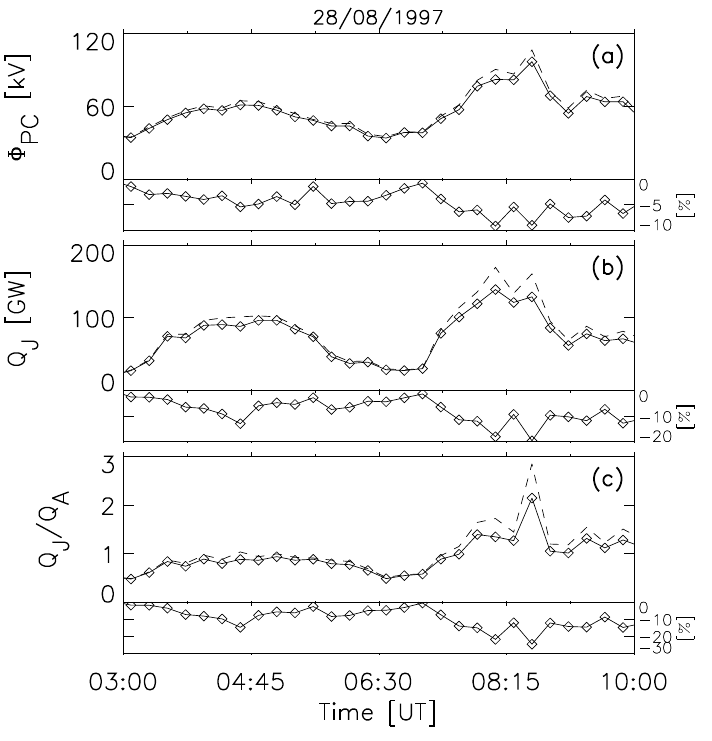
Fig. 13. The AE , AL and D st -indices between 00:00 and 12:00 UT on 28 Au- gust 1997. AE and AL are calculated from 68 stations between 55 and 76 ◦ in magnetic latitudes. D st is calculated from 16 stations below 40 ◦ in magnetic latitudes. The two vertical dashed lines indicate our time interval with data be- tween 03:00 and 10:00 UT.